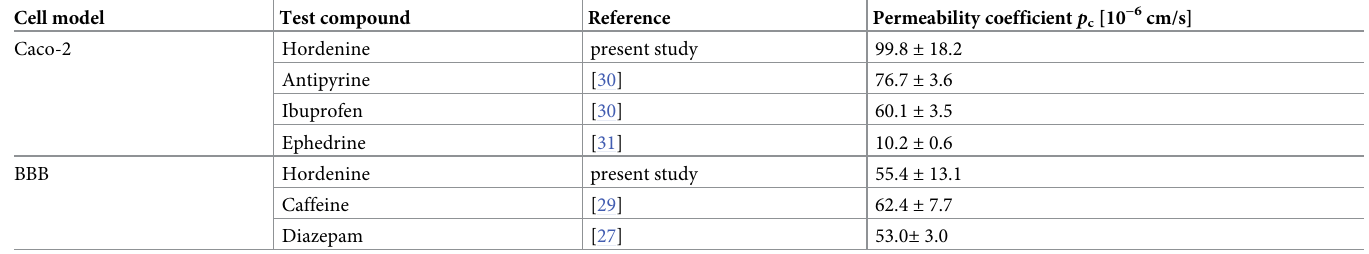
Table 2. Permeability coefficients of hordenine calculated in the Caco-2 and BBB model in comparison to test compounds with their literature reference. Perme- ation of hordenine from apical to basolateral compartment of the Caco-2 or PBCEC monolayer with apical application of 1 μ M hordenine (passive transfer study, n = 3 ×